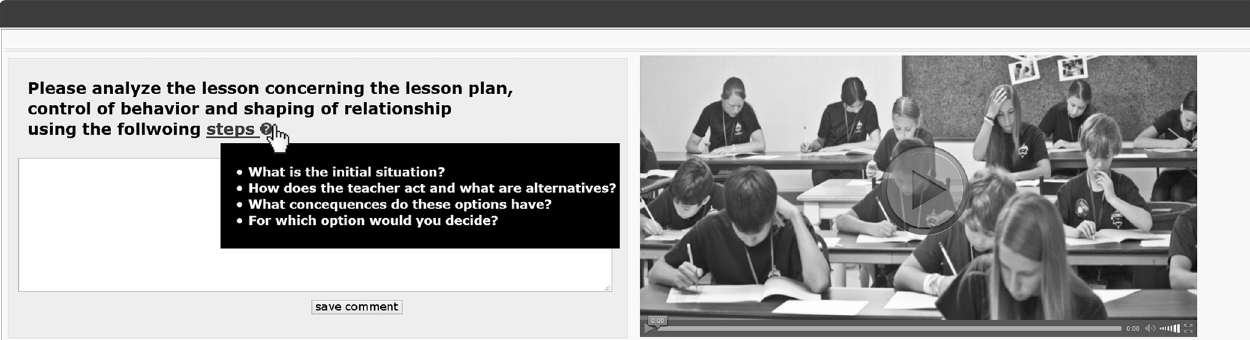
Fig 1. Screenshot of the web-based survey: One of three vignettes to be analyzed by students.